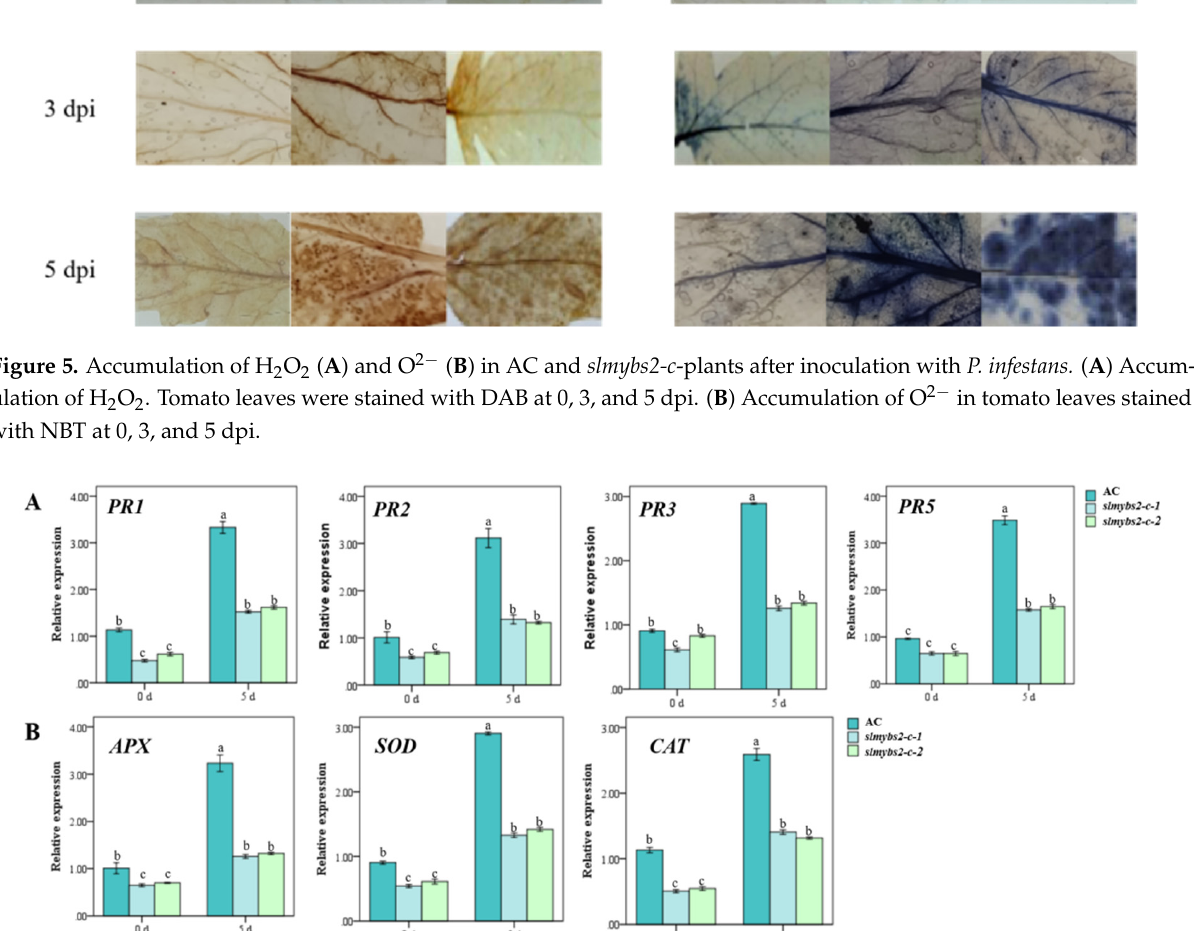
Figure 6. Knocking out SlMYBS2 affected the expression of ROS generation- and scavenging-related and defense-mediated genes after infection with P. infestans . ( A ) Expression of defense-related genes( PR1, PR2, PR3, PR5 ). ( B ) Expression of ROS generation- and scavenging-related genes ( APX, SOD, CAT ). Relative expression levels are shown as fold changes in actin transcript values. The data are presented as the means ± SDs from three independent experiments, and the different lowercase letters indicating significant differences at the 0.05 level.